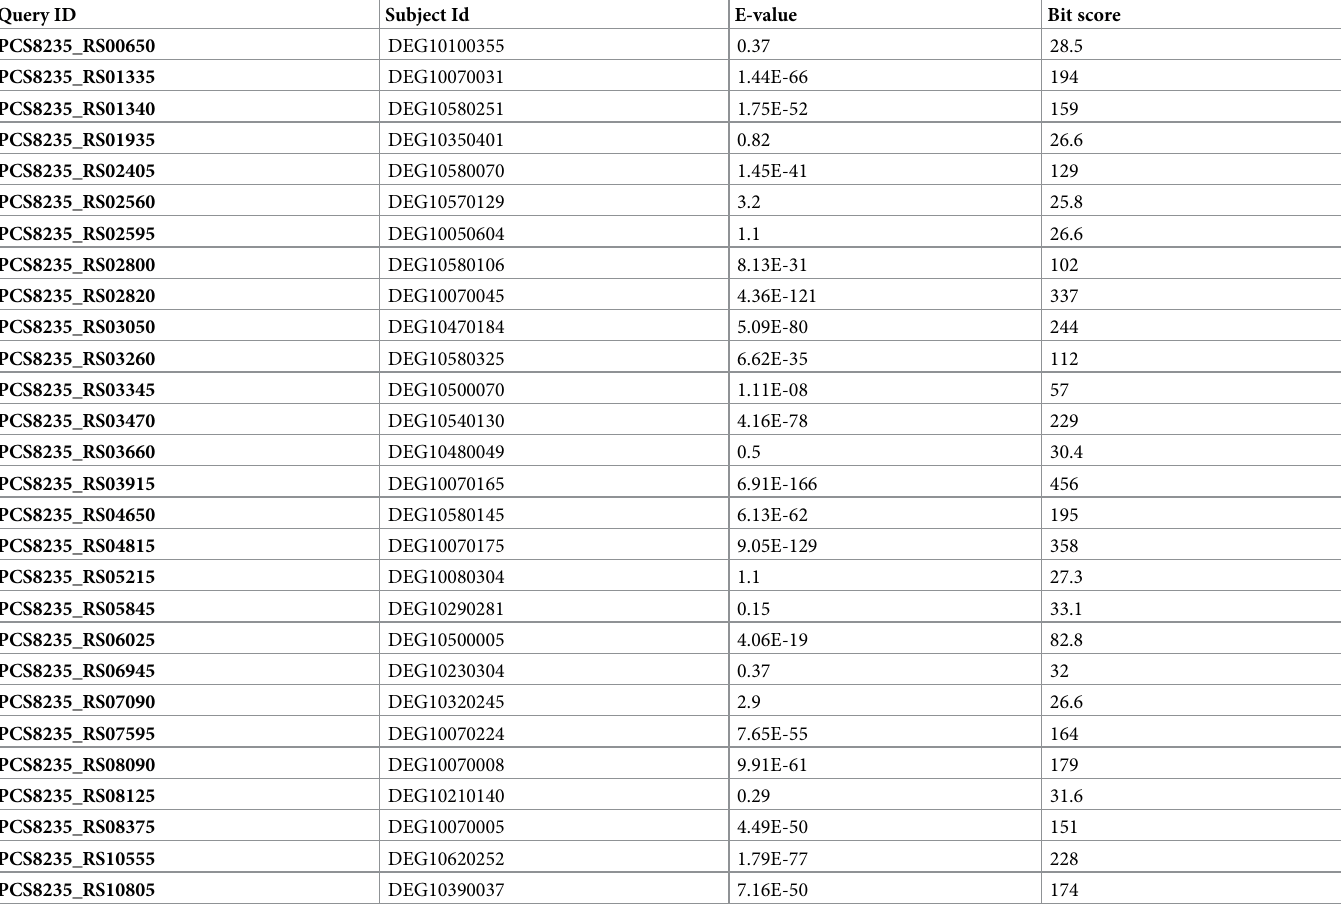
Table 3. Essential proteins as identified by the DEG database. More than half of the proteins were found to be essential. Query